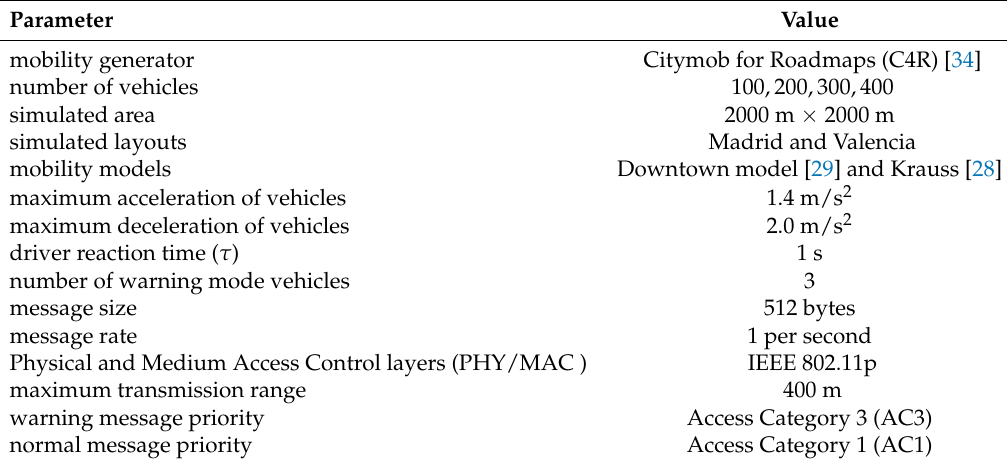
Table 2. Parameter values for the